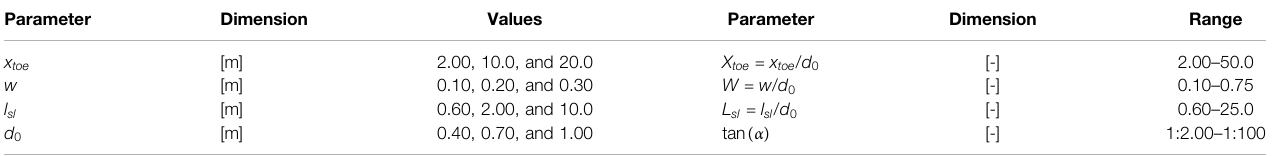
TABLE 2 | Values of the parameters varied (left) and normalized parameter range